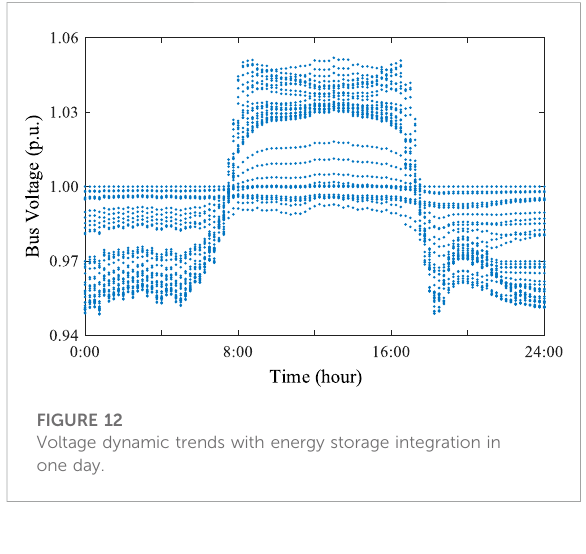
FIGURE 12 Voltage dynamic trends with energy storage integration in one day.